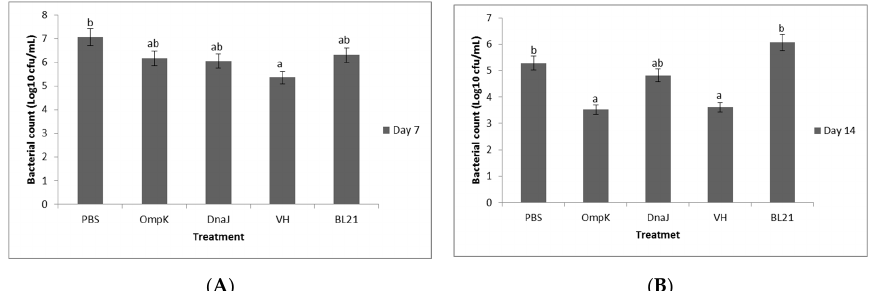
Figure 8. Bacterial count (cfu/mL) in the serum of non-vaccinated and vaccinated juvenile seabass at ( A ) days 7 and ( B ) day 14 post-vaccination. Significant differences are indicated by different letters ( p < 0.05).